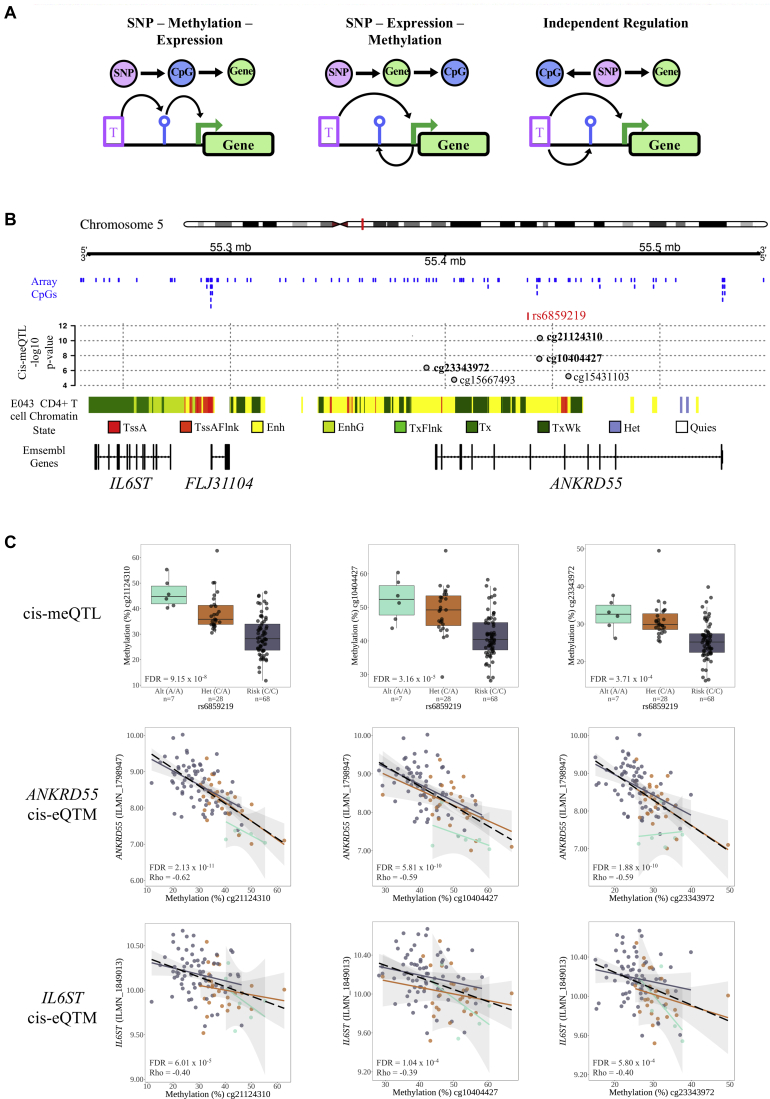
DNAm-mediated transcriptomic regulation of ANKRD55 and IL6ST at the risk locus on chromosome 5q11.2 in CD4+ T cells. A, Potential regulatory models explaining the association between genotype at-risk variants and associations with both DNAm status at CpGs in cis and transcriptional activity at proximal genes. B, The RA risk variant rs6859219 (red line) at chromosome 5q11.2 is associated with DNAm at 4 intronic and 1 intergenic (cg23343972) CpG sites (gray circles), mapping to CD4+ T-cell enhancer elements (yellow). Blue lines indicate the position of all CpG sites included in the meQTL analysis. C, meQTL (top) and eQTM plots for 3 of the 5 CpG sites associated with the rs6859291 risk variant; linear regression lines displayed with CIs for each genotype subset; black dotted line depicts linear regression across all samples. All 5 CpGs in Fig 4, B, displayed associations with transcript levels of both the ANKRD55 and the upstream IL6ST genes, and CIT confirmed methylation-mediated regulation of these transcripts for cg21124310, cg10404427, cg23343972, and cg15431103 (Table II).